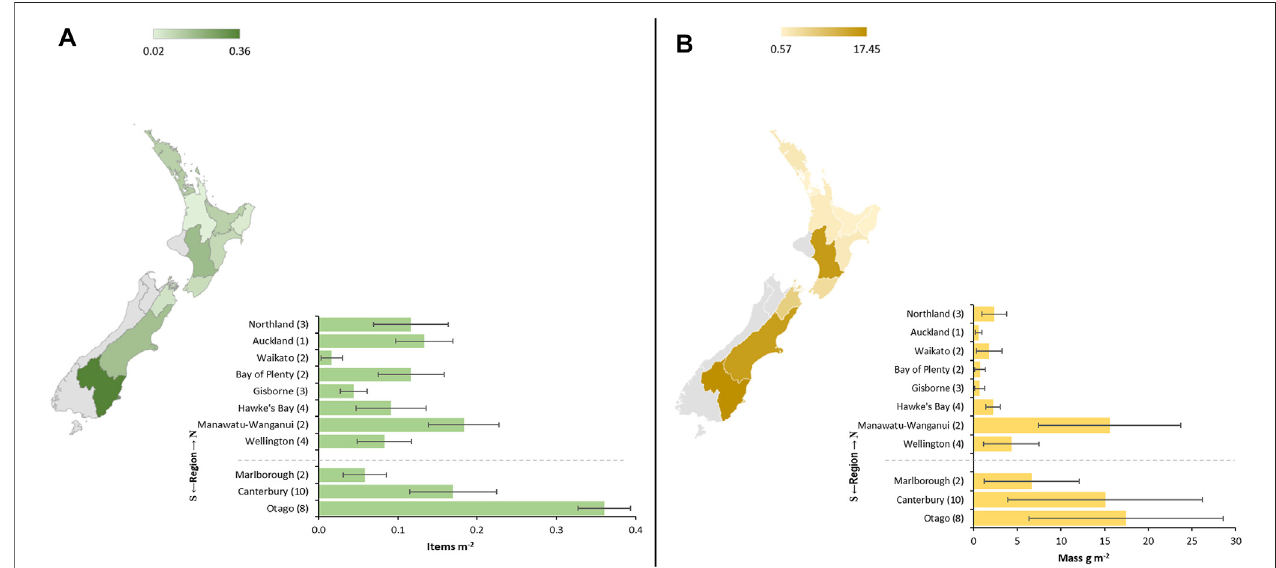
FIGURE3| New ZealandBeach AnthropogenicMarineDebris ( > 2 mm)per Region(Number ofBeaches)inSpring2017by (A) MeanDensity( ± SE)and (B) Mean Weight ( ± SE).